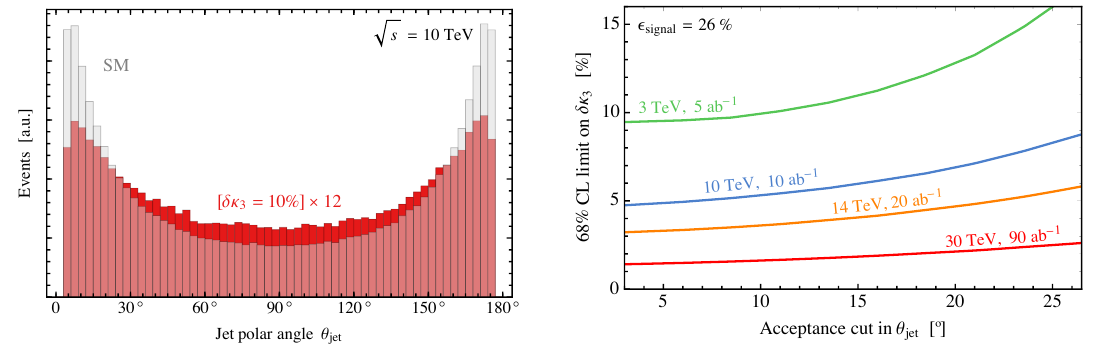
√ s = 10 TeV in the SM